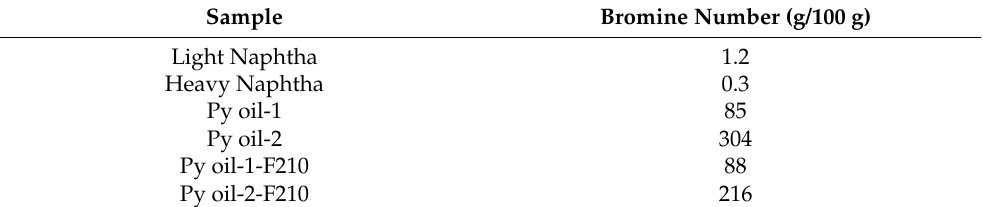
Table 3. Bromine number of the pyrolysis oils and naphtha samples.